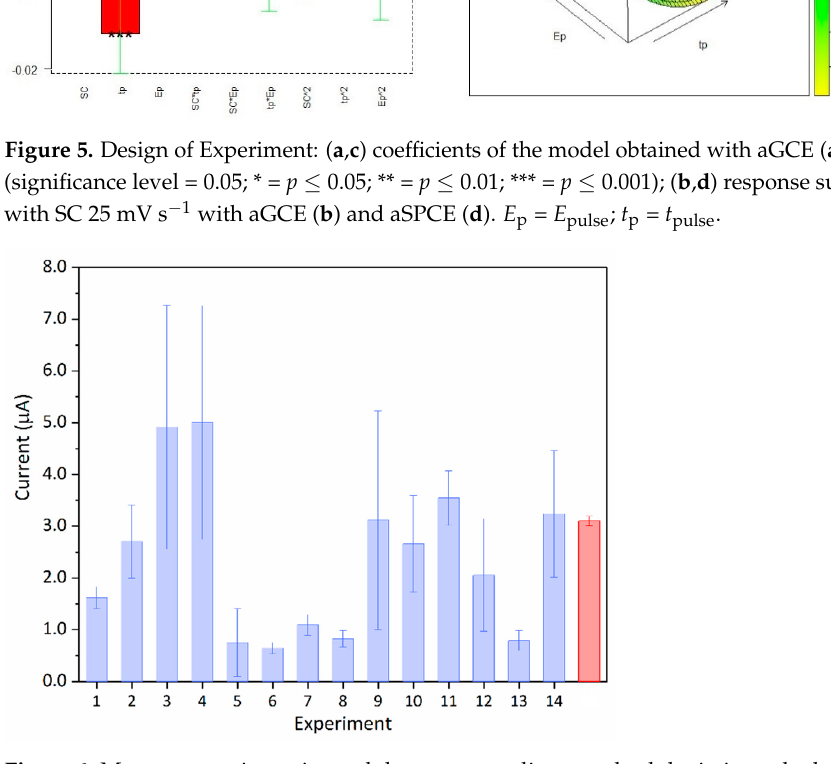
Figure 6. Mean current intensity and the corresponding standard deviation calculated on the three measurement replicates of each DoE experiment conducted with the aGCE. The red bar identifies the measurement results obtained with optimized